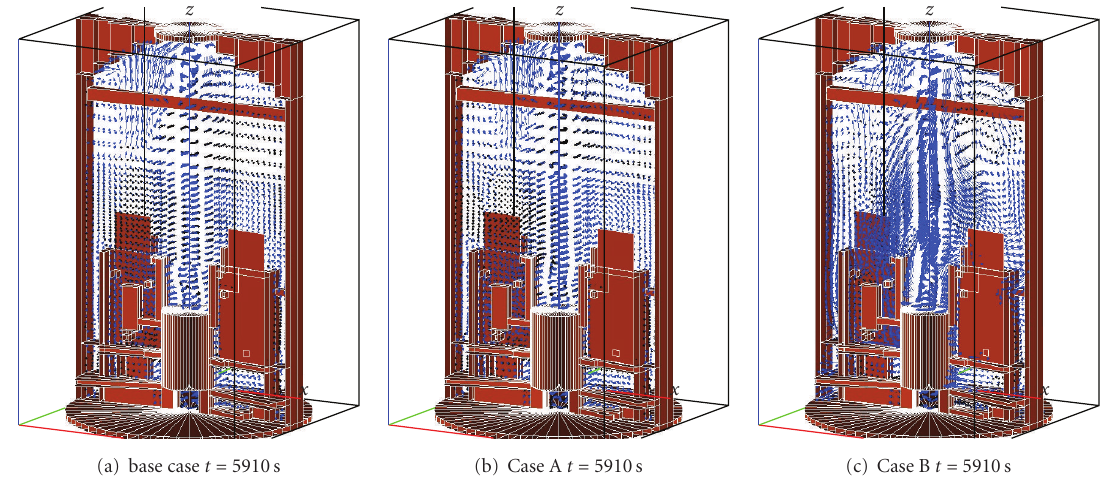
Figure 9: Flow fields during the hydrogen release peak.